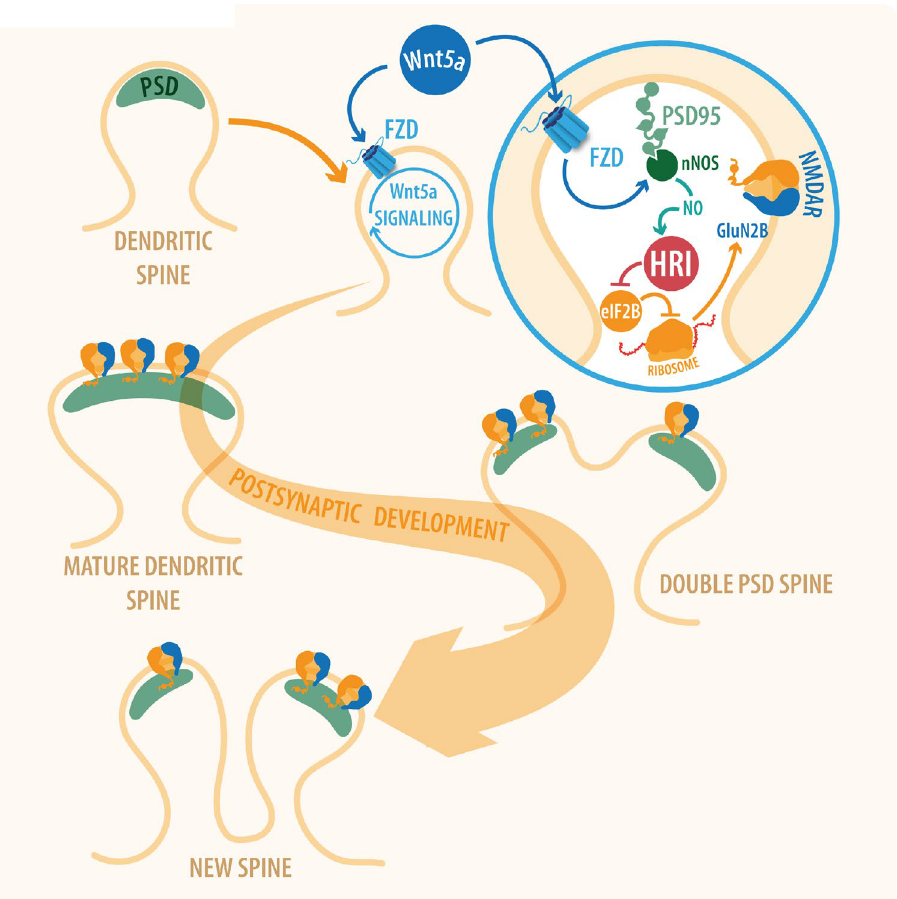
Figure 8. Wnt5a/NO/HRI signaling pathway promotes GluN2B translation and postsynaptic development. Wnt5a by binding to Fzd (Frizzled) receptor increases intracellular calcium and stimulates the production of NO, activating the HRI kinase. When HRI is active, it produces the translation of postsynaptic proteins like GluN2B subunits. This protein synthesis favors the maturation and formation of new dendritic spines. Felipe Serrano (Illustrative-science) designed the model of the signaling